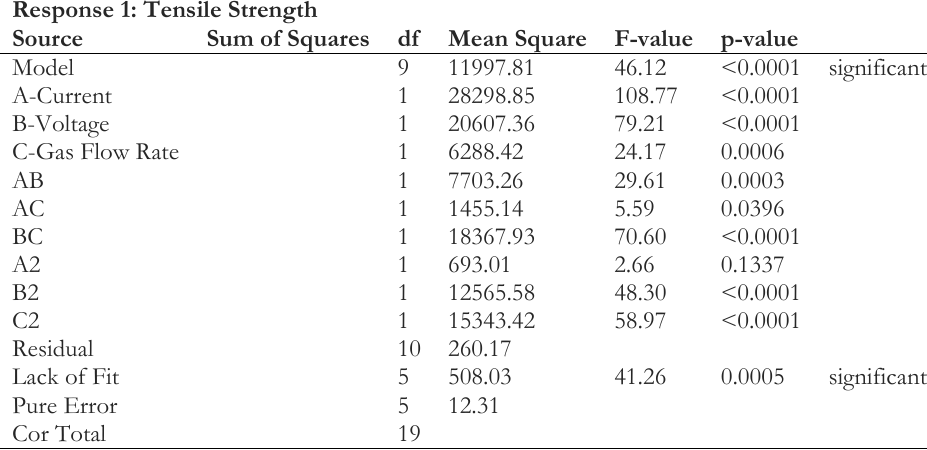
Table 3. ANOVA for quadratic model.